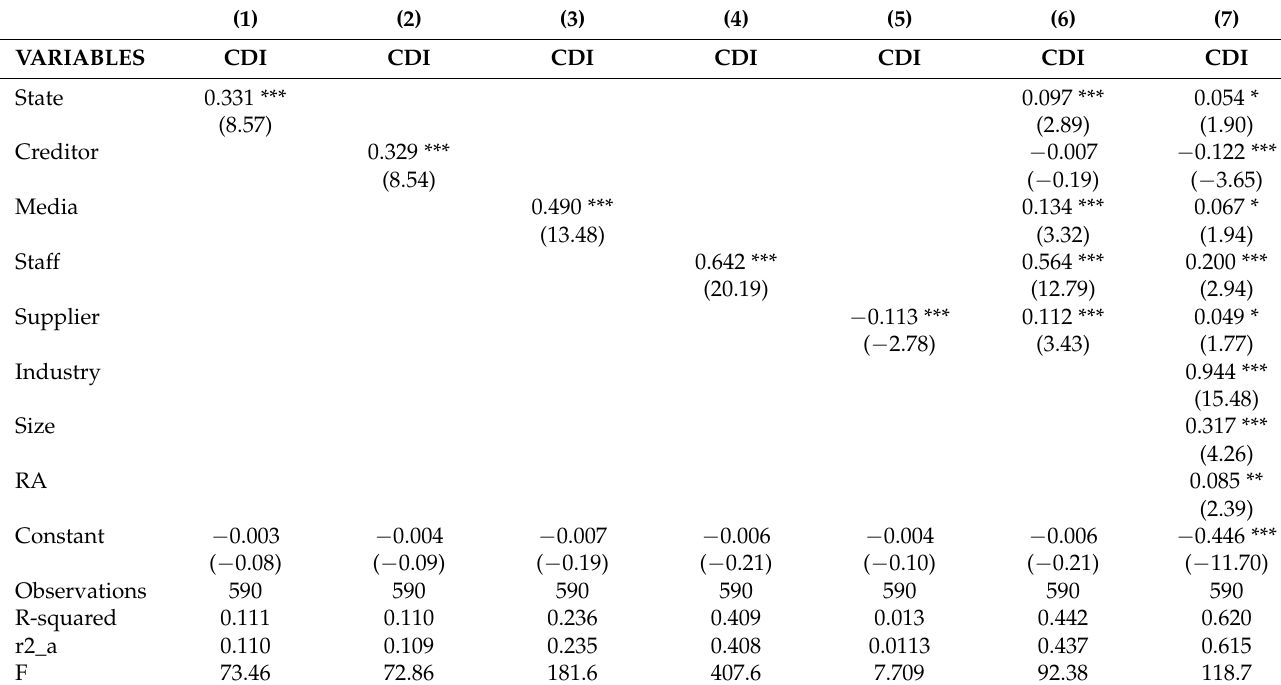
Table 7. Robustness test results (after tailing